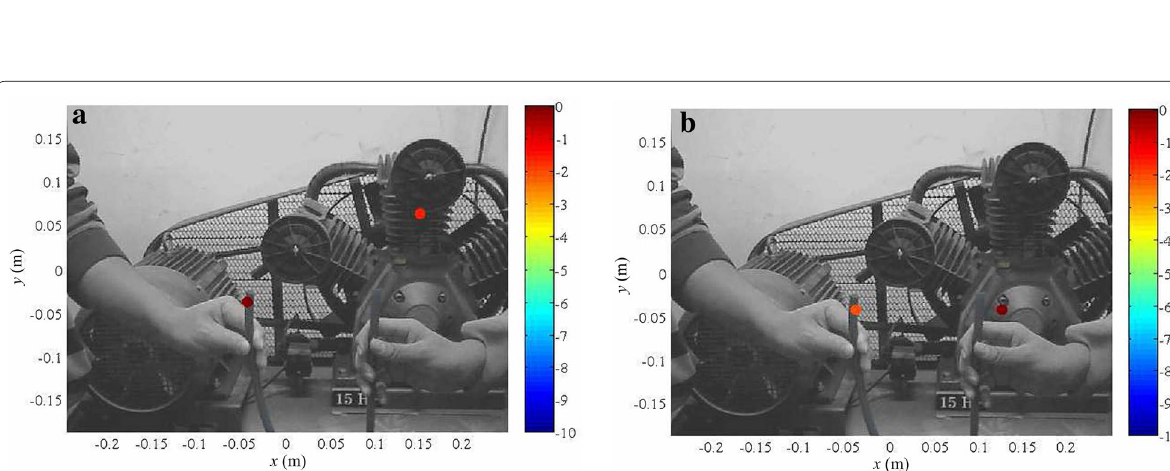
Figure 14 Source maps for the gas leakage experiment are obtained by: a DCS-SOMP method, and b DCS-SOMP-SVD method when the frequency range equals 6500 ‒ 7000